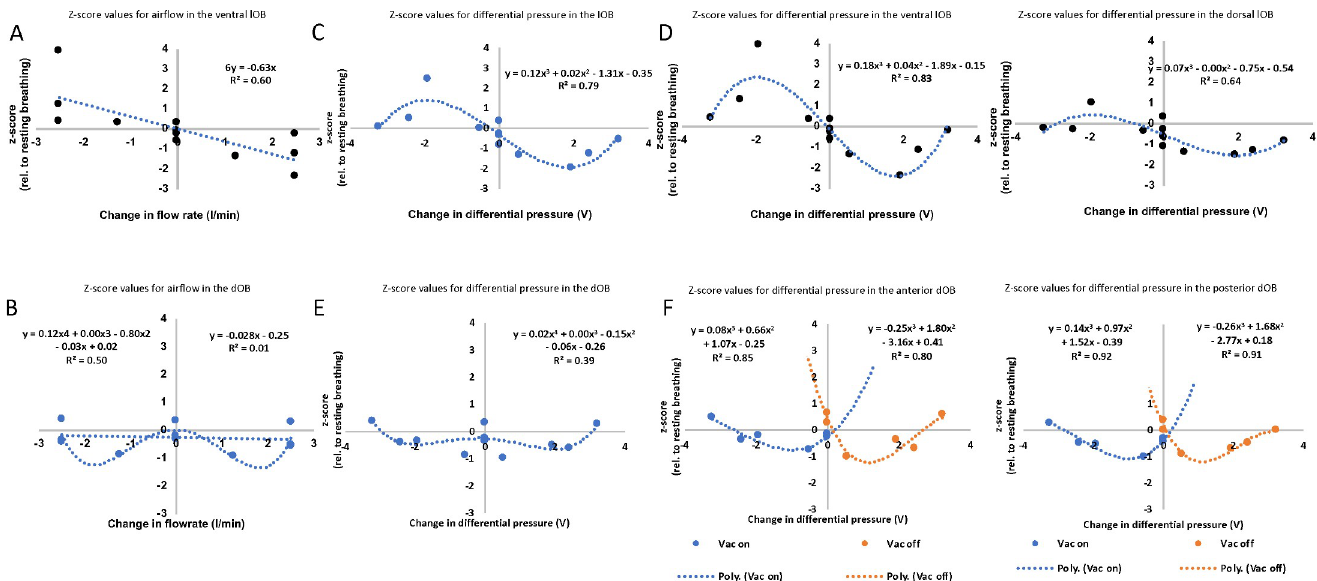
Fig 6. The lOB is sensitive to differential pressure. (A) Mean z-scored OB responses to different flow rates in the ventral lOB. (B) Mean z-scored OB responses to different flow rates in the dOB. (C) Mean z-scored OB responses to different pressure changes in the lOB. (D) Mean z-scored OB responses to different pressure changes in the lOB. Left: the ventral lOB. Right: the dorsal lOB. (E) Mean z-scored OB responses to different pressure changes in the dOB. (F) Mean z-scored OB responses to different pressure changes in the dOB. Left: the anterior dOB. Right: the posterior dOB: 3 animals; dOB: 99 glomeruli; and lOB: 47 glomeruli. Graphs are reorganized from S4C and S4D Fig, all offset by respective z-scores for no–flow-change condition (0–0, room; see Methods). Only the lOB—and the vlOB in particular—shows a strong and positive response to an intermediary drop in pressure at the odor delivery tube. The dOB only shows mild response suppression, particularly by intermediate changes in pressure. Pressure unit is relative only. Underlying data for this figure can be found in S1 Data. dOB, dorsal olfactory bulb; lOB, lateral olfactory bulb; OB, olfactory bulb; vlOB,